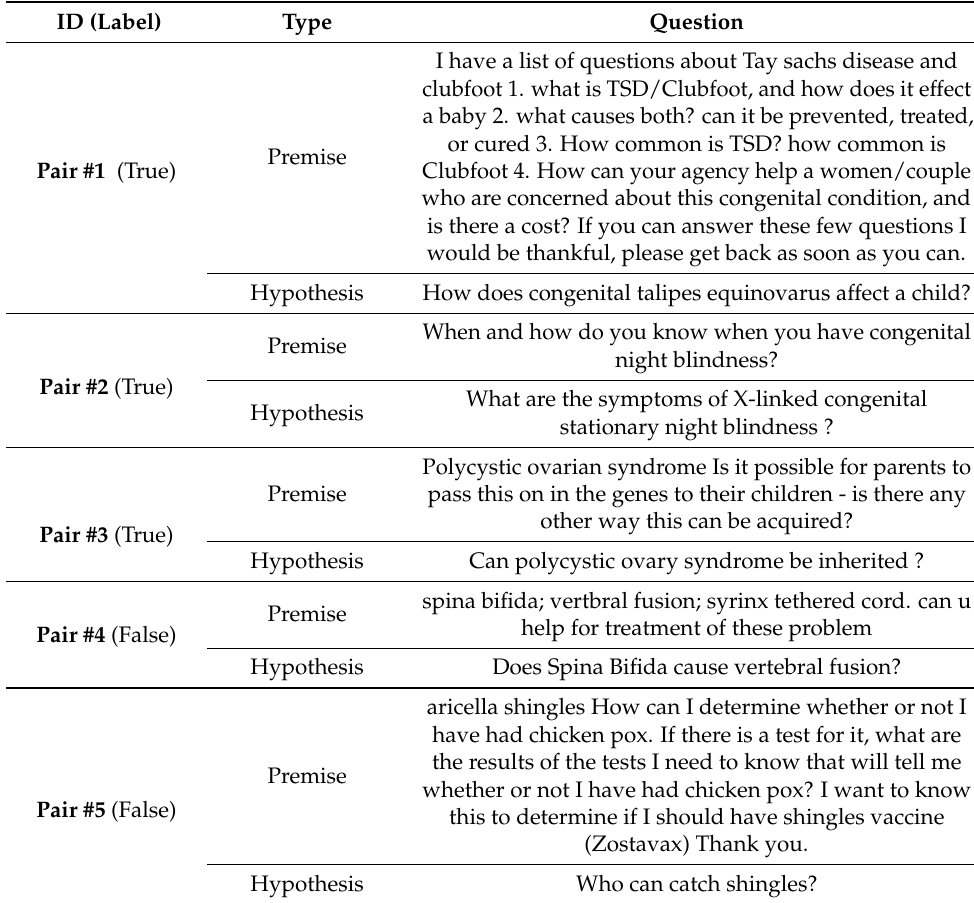
Table 3. MEDIQA-RQE test set examples: premise–hypothesis pair